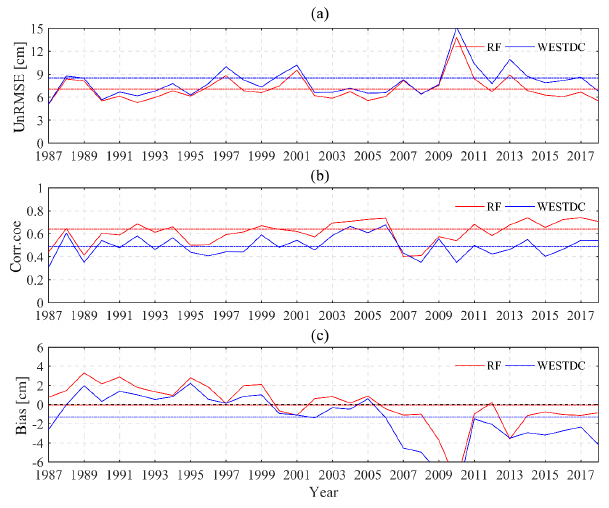
Figure 8. Time series of (a) unbiased RMSE (unRMSE), (b) corre- lation coefficient (corr.coe), and (c) bias for RF and WESTDC prod- ucts. The colorful dashed lines represent mean values of assessment indexes.